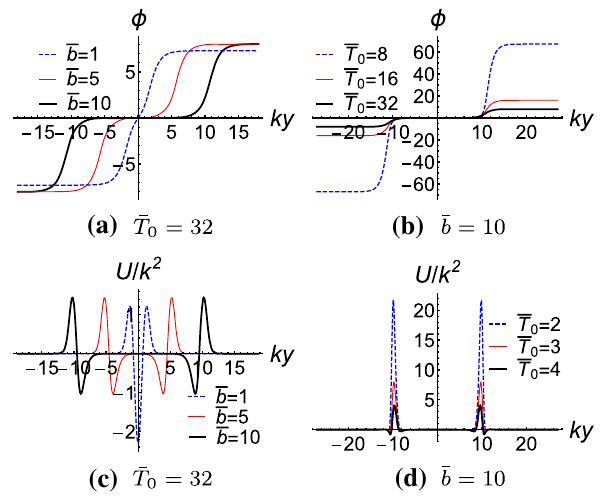
Fig. 10 Plots of the scalar field and the effective potential for f ( T ) = − ¯ T 0 k